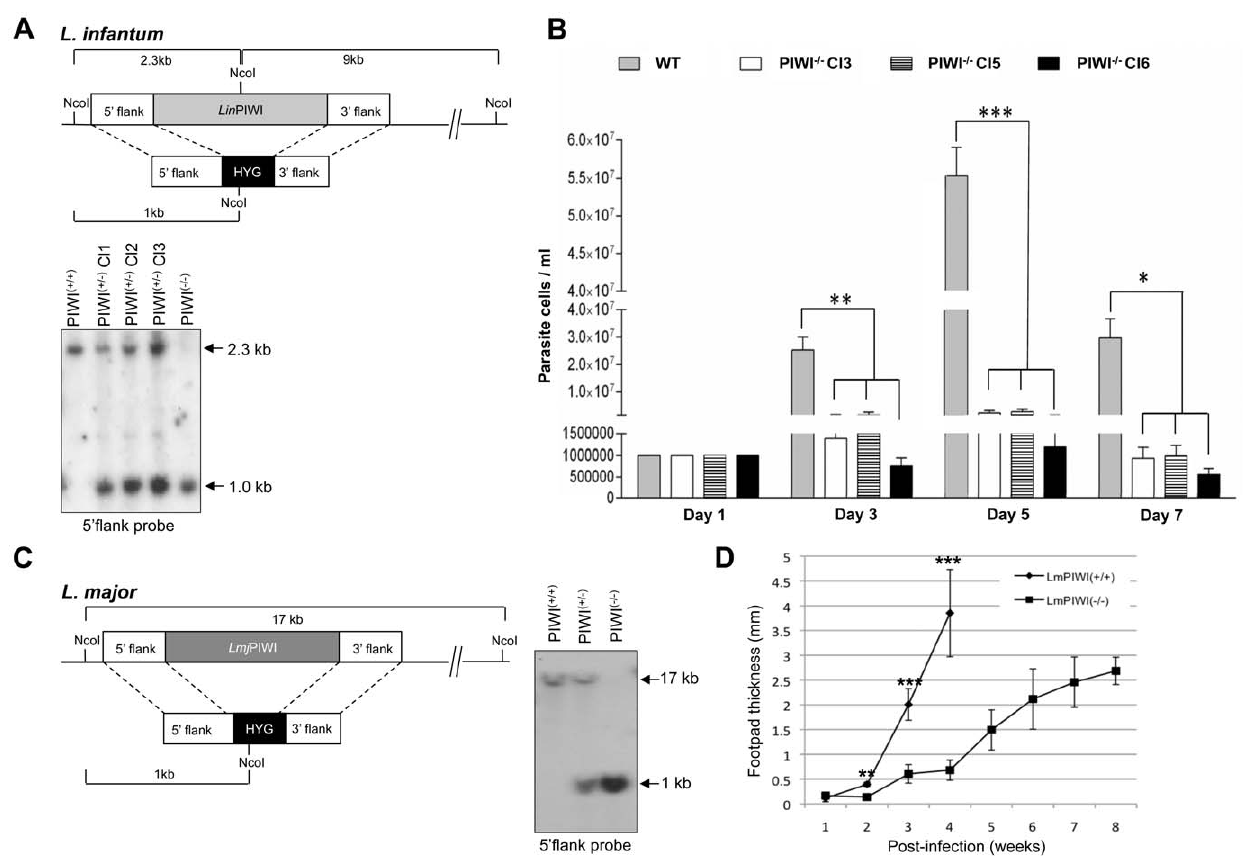
Figure 4. Genomic inactivation of the PIWI gene in L.infantum and L.major strains leads to a decrease in amastigote growth and disease pathology. (A, upper panel) Strategy to inactivate the L. infantum PIWI gene ( Lin PIWI ( 2 / 2 ) ) by genetic replacement. Both alleles of the LinPIWI single copy gene were replaced by the hygromycin phosphotransferase gene ( HYG ) by a loss of heterozygocity. (A, bottom panel) Southern blot hybridization of L. infantum genomic DNA digested with NcoI using the PIWI 5 9 flank sequence as a probe. In Lin PIWI ( + / + ) , only a 2.3 kb band which corresponds to the wild type alleles was detected. In Lin PIWI ( + / 2 ) clones (C1, C2 and C3), in addition to the wild type allele, one more band of 1.0 kb (for the HYG gene integration) was detected. In Lin PIWI ( 2 / 2 ) , only one band of 1.0 kb (for the HYG gene replacement) was detected but not the 2.3 kb band. (B) Growth curve of L. infantum axenic amastigotes for Lin PIWI ( + / + ) and Lin PIWI ( 2 / 2 ) independent clones 3, 5 and 6. The growth pattern of L. infantum WT and Lin PIWI ( 2 / 2 ) clones on days 1, 3, 5 and 7 was analyzed by one-way ANOVA followed by a Tukey’s post-test using GraphPad Prism (version 3.03) software. Significant differences between the various groups are indicated (*, P , 0.05; **, P , 0.01; and ***, P , 0.001). (C, left panel) Strategy to generate a PIWI null mutant in L. major ( Lmj PIWI ( 2 /) ). The LmjPIWI alleles were replaced by the HYG expression cassette by a single round of gene targeting. (C, right panel) Southern blot hybridization using the L. major PIWI 5 9 flank sequences as a probe. The 17 kb band corresponds to the PIWI wild type alleles and the 1.0 kb band corresponds to the HYG gene integration into the PIWI genomic locus. (D) L. major infection rates in mice estimated by measuring the size of footpad lesions at different time points post-infection in BALB/c mice infected with either the wild type ( Lmj PIWI ( + / + ) ) strain or the Lmj PIWI ( 2 / 2 ) null mutant (clone 1). Control mice were sacrificed at 4 weeks post-infection due to the larger size of the lesions. Data shown here are the mean 6 SD of 6 mice per group and are representative of three independent experiments. The footpad thickness of L. infantum WT and Lmj PIWI ( 2 / 2 ) null mutant on weeks 1, 2, 3 and 4 was analyzed by t-test (non parametric) using GraphPad Prism (version 3.03) software. Significant differences between WT and Lmj PIWI ( 2 / 2 ) are indicated (**, P , 0.01 and ***, P , 0.001). which further supports the specificity of the role of PIWI protein in the amastigote growth of the parasite.